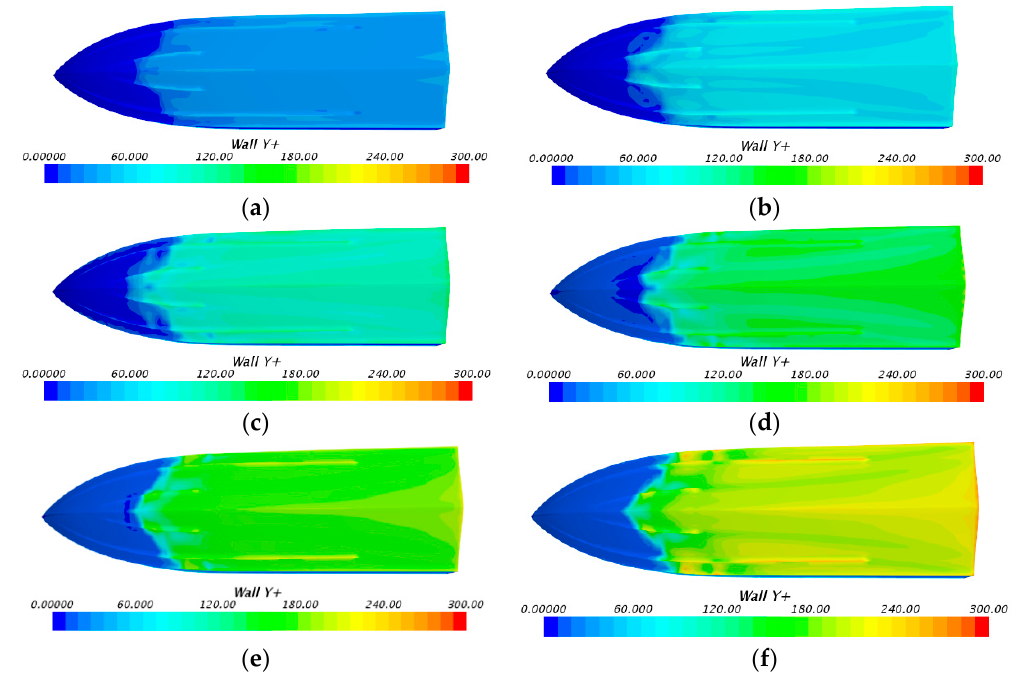
Figure 12. Wall non-dimensional distance of the first layer grid ( y +) after calculation: ( a ) y + = 50; ( b ) y + = 100; ( c ) y + = 150; ( d ) y + = 200; ( e ) y + = 250; ( f ) y + = 300.